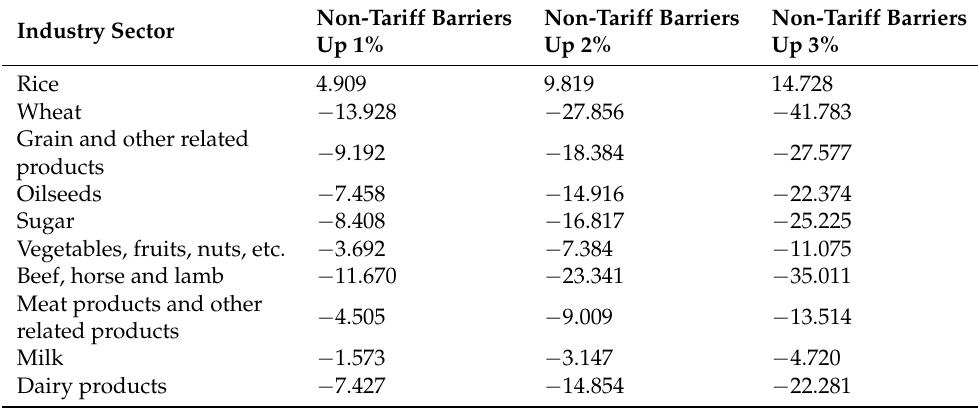
Table 10. Impact of changes in non-tariff barriers on the import volume of different agricultural